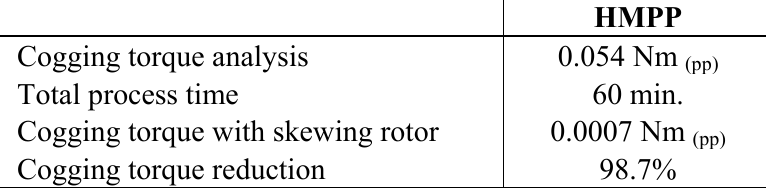
Table 4. Cogging torque obtained from the proposed HMPP method of the 100-pole, 96-slot wind